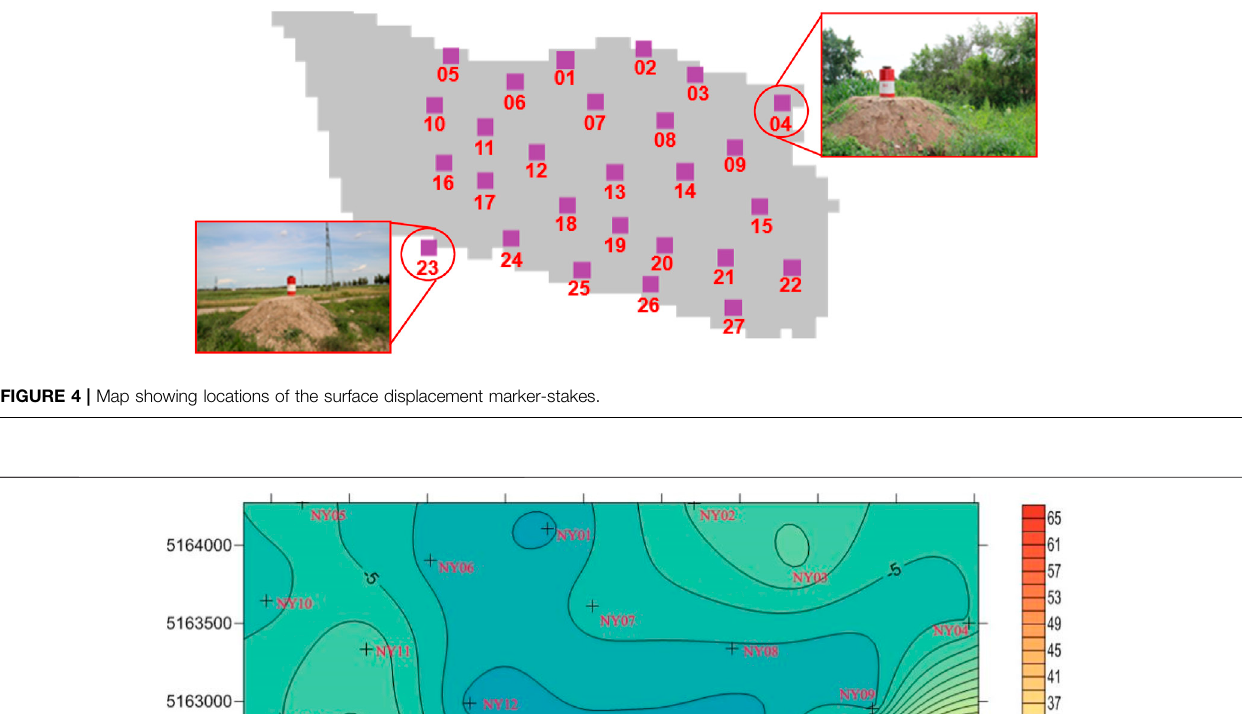
Frontiers in Earth Science |